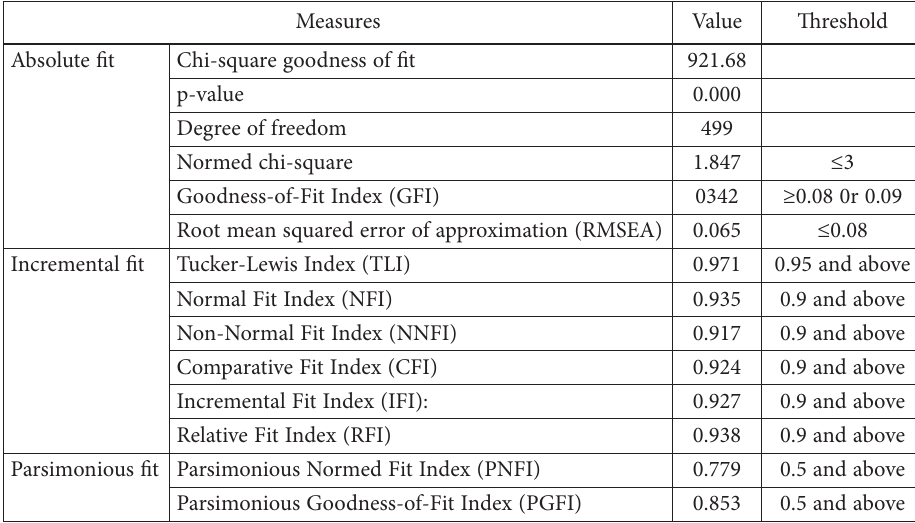
Table 3. Goodness-of-fit indices of the structural